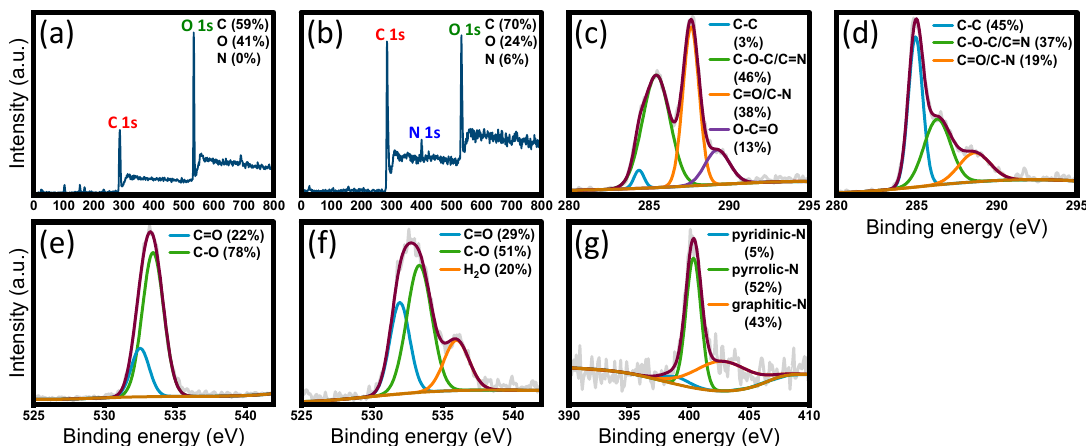
Figure 5. Full-scan XPS surveys for ( a ) GO and ( b ) rGO reduced by S. decolorationis NTOU1; XPS C 1s spectra for ( c ) GO and ( d ) rGO reduced by S. decolorationis NTOU1; XPS O 1s spectra for ( e ) GO and ( f ) rGO reduced by S. decolorationis NTOU1; XPS N 1s spectra for ( g ) rGO reduced by S. decolorationis NTOU1. Gray lines, raw data of the experiments; dark red lines, the envelope curve fittings; light brown lines, baselines.